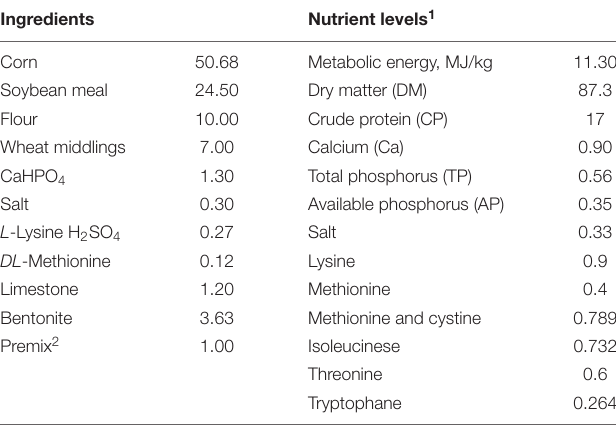
TABLE 1 | Ingredients and nutrient composition of the basal diet (dry matter basis,